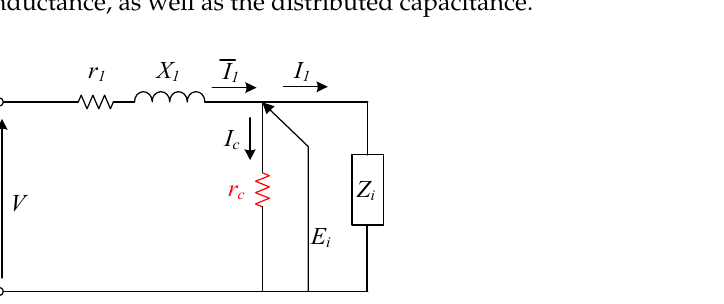
Figure 4. Per-phase ECM with predictable core loss of PMSMs